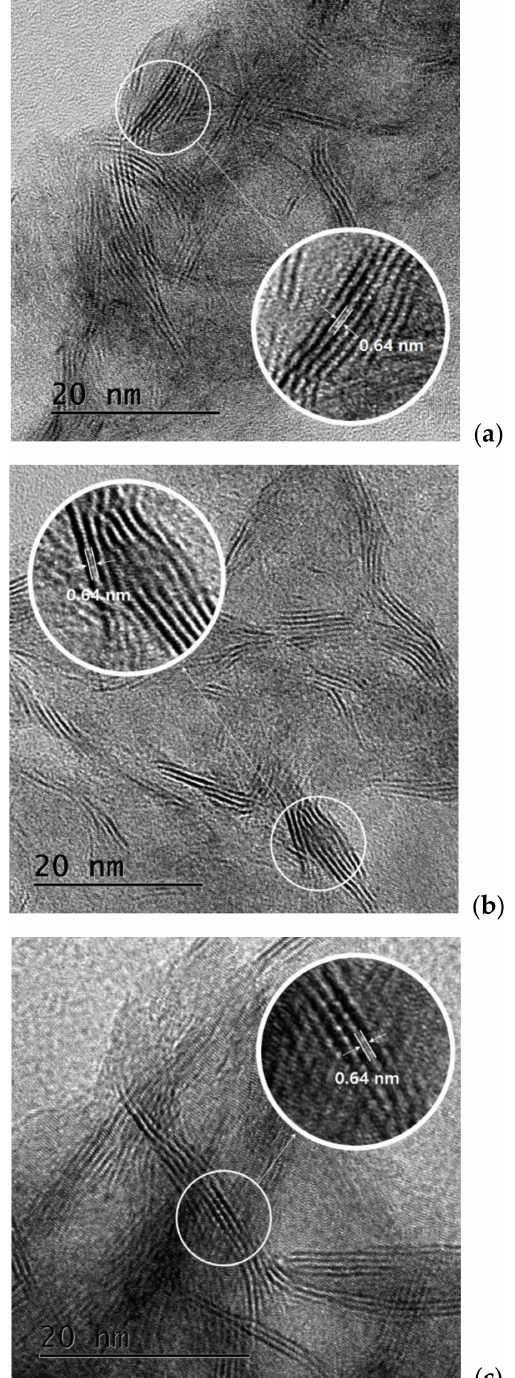
Figure 3. HRTEM images of MoS 2 prepared at ( a ) pH 4.5; ( b ) pH 7.0; and ( c ) pH